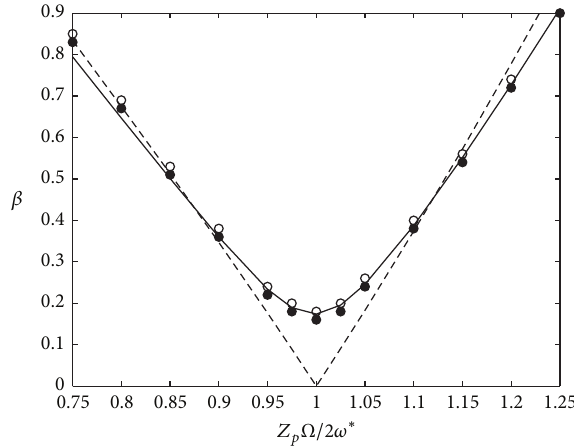
Figure 8: Dynamic instability region of a rotating ship shaft with 𝑍 𝑝 = 5 and 𝜁 = 0.05. “—,” “- -,” instability region boundary with 𝑍 𝑝 = 5 𝜁 = 0 by Floquet’s method, “ e ,” “ I ,” stable and 𝜁 = 0.05 and 𝑍 𝑝 = 5 unstable data with 𝑍 𝑝 = 5 𝜁 = 0.05 by DSC method.